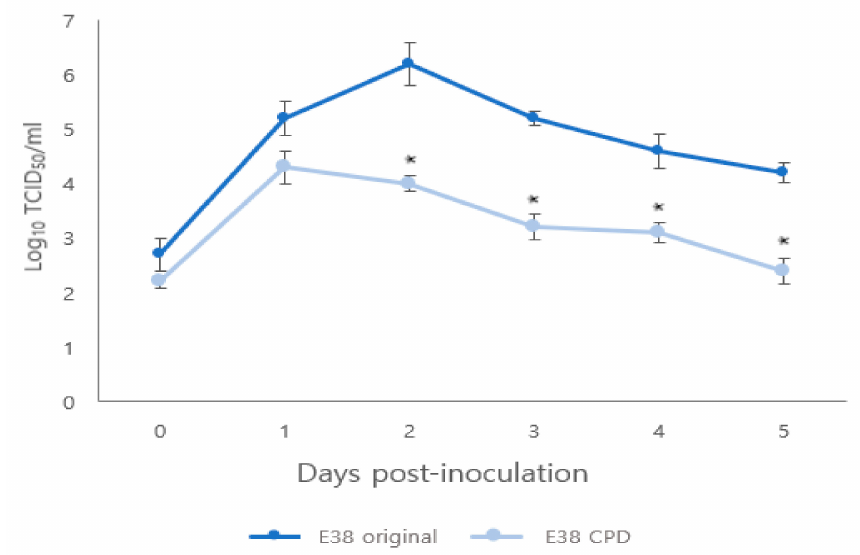
Figure 2. Comparison of replication kinetics of original and CPD viruses in PAM cells. The virus titers are presented as TCID 50 . Significant difference ( p < 0.05) is indicated by